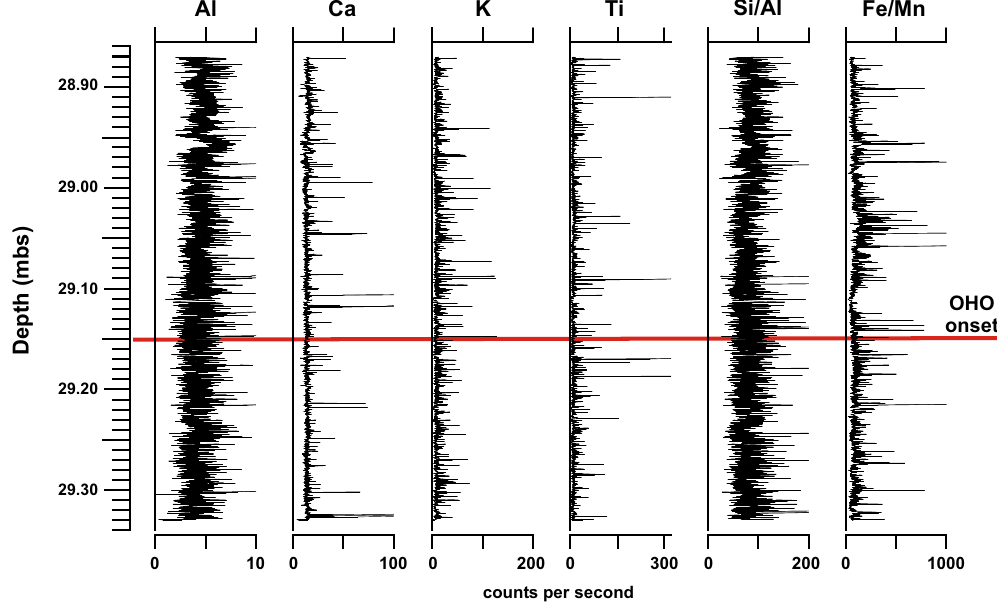
Fig. 8. Geochemical results of µ-XRF (step size: 100µm) spanning ∼ 90yr before the onset and ∼ 150yr into the Older Holsteinian Oscillation (OHO). The position of the OHO is defined by a strong and abrupt decline of temperate tree taxa percentages in the Dethlingen core (Koutsodendris et al.,